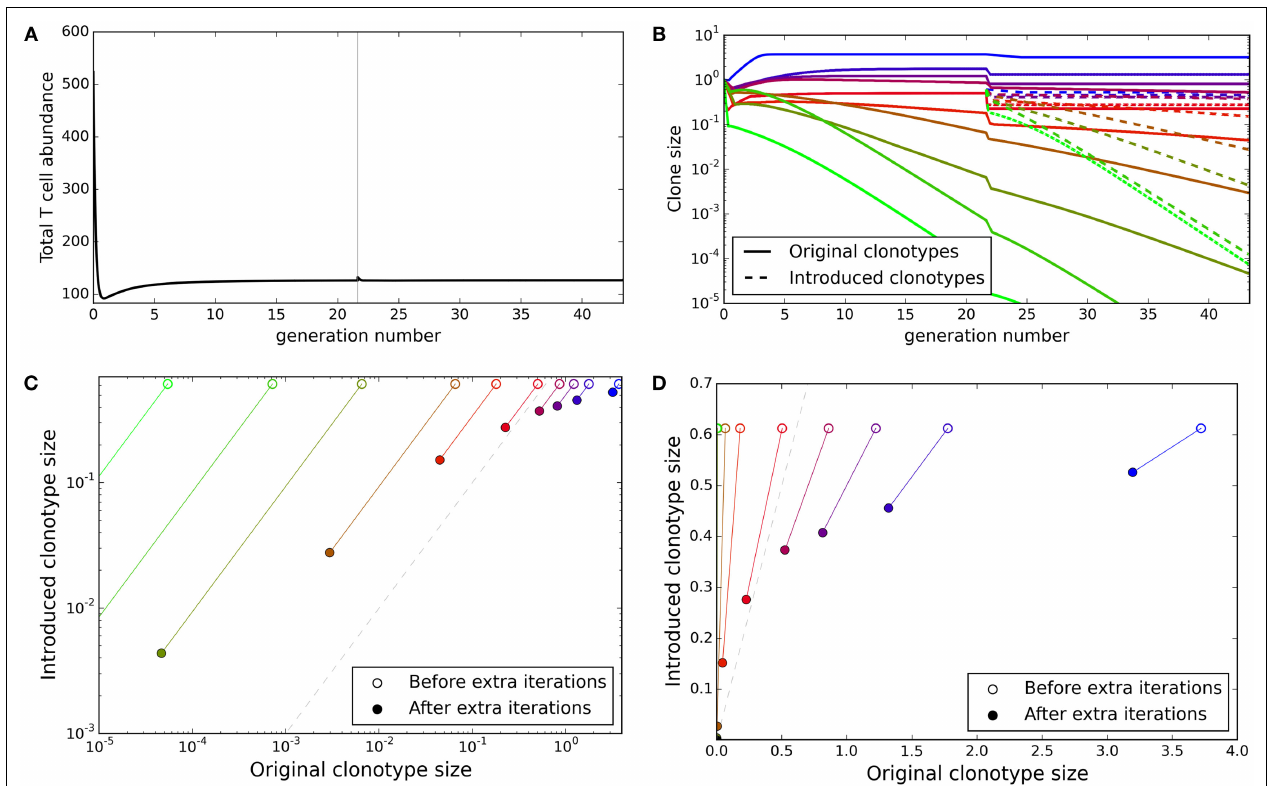
binding strength-matched introduced clonotypes, the relationship between the original and match clone abundance when the new clonotype is introduced (open circles) and after running the simulation for an additional 30,000 iterations of the update algorithm (solid circles). The dashed gray line represents identical abundance of original and introduced clonotypes. Model parameters used for all panels are: self-response threshold (cid:28) = 1, growth rate (cid:23) = ln 2 (cid:14) t –1 , learning rate (cid:17) = 0.002001 (cid:14) t –1 , proportion of non-zero affinities (cid:13) = 0.01, number initial clonotypes N = 1,000, number self profiles M =